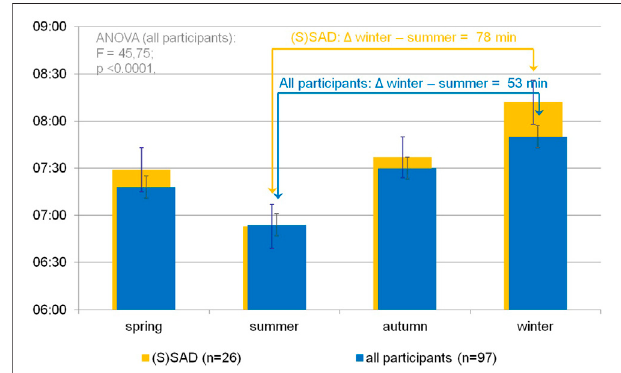
FIGURE 3 | Seasonal variation of subjective sleep duration in an urban environment. Blue bars indicate self-reported sleep durations (hh:mm) per season as noted on the x -axis according to the Seasonal Pattern Analysis Questionnaire item 16 (Rosenthal and Wehr, 1984) in the whole sample. A one-way repeated-measures ANOVA shows signi fi cant differences in sleep durations between seasons. Single comparisons ( t test) show signi fi cant differences between all pairs after Bonferroni correction for multiple testing ( p < 0.01). Orange background bars show sleep durations in subgroup (participants categorized as SAD or subsyndromal SAD). Error bars indicate standard error of mean.